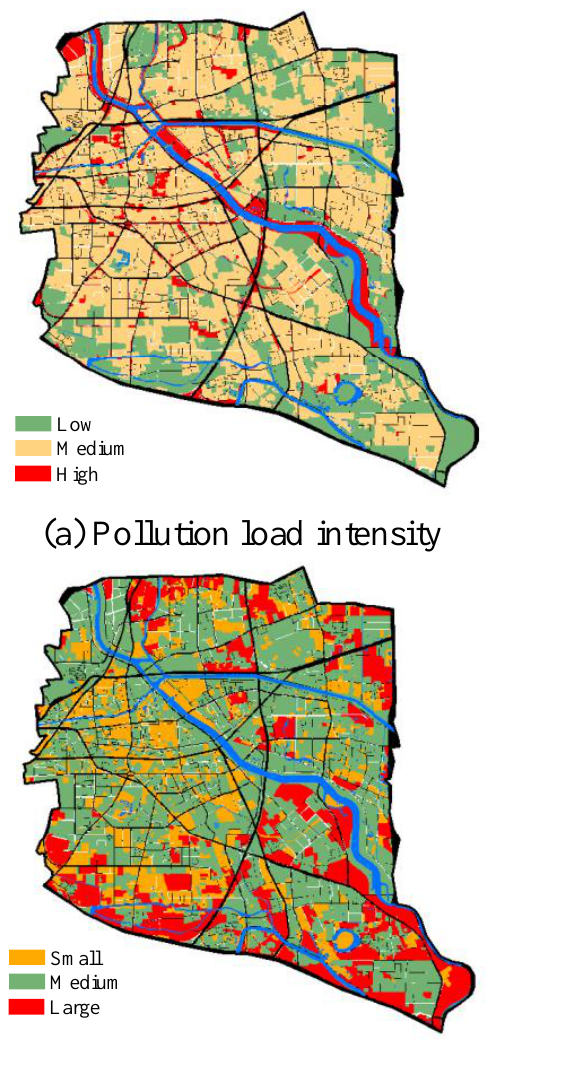
Figure 3. The distribution of site suitability indexes for GI. GI’s runoff control effects are weighted similarly and are highly recognized by stake- holders. But the weight of runoff reuse is not as high as runoff quality and quantity control efficiency. The equipment investment and maintenance costs have relative weights in terms of GI cost. Landscape and space vitality plays a similar role in the social advantages of GI. GIs are given equal importance in landscape aesthetics and spatial vitality indicators. The weight values in Table 5 demonstrate that trade-offs between runoff control, cost input, and social benefit are required for GI